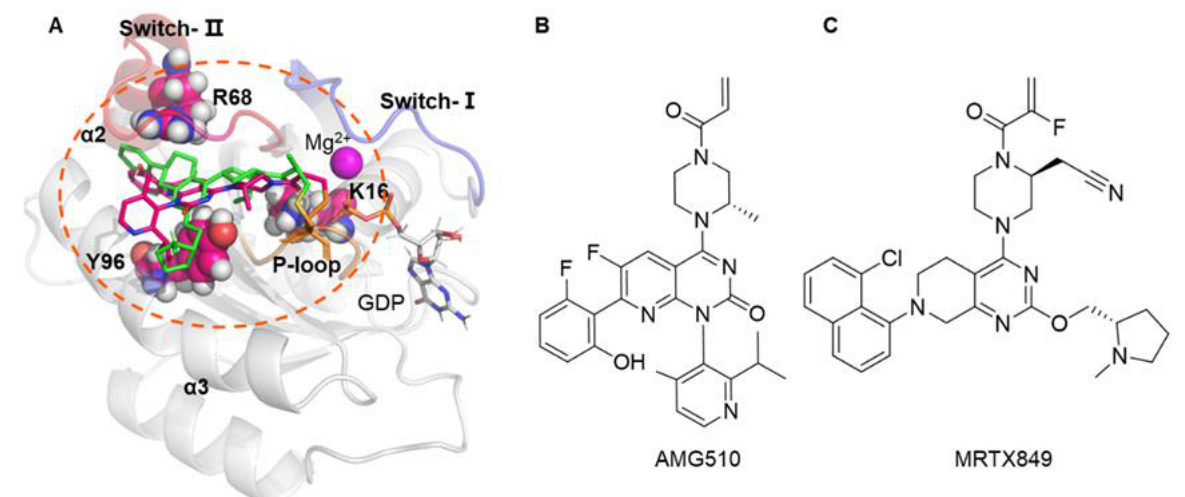
Figure 1. ( A ) Overall structure of the KRAS G12C complex with AMG510 and MRTX849. The protein and ligand are shown as cartoons and stick, respectively. The mutated residues in switch-II binding pocket are shown as sphere. ( B , C ) Chemical structure of AMG510 and MRTX849.